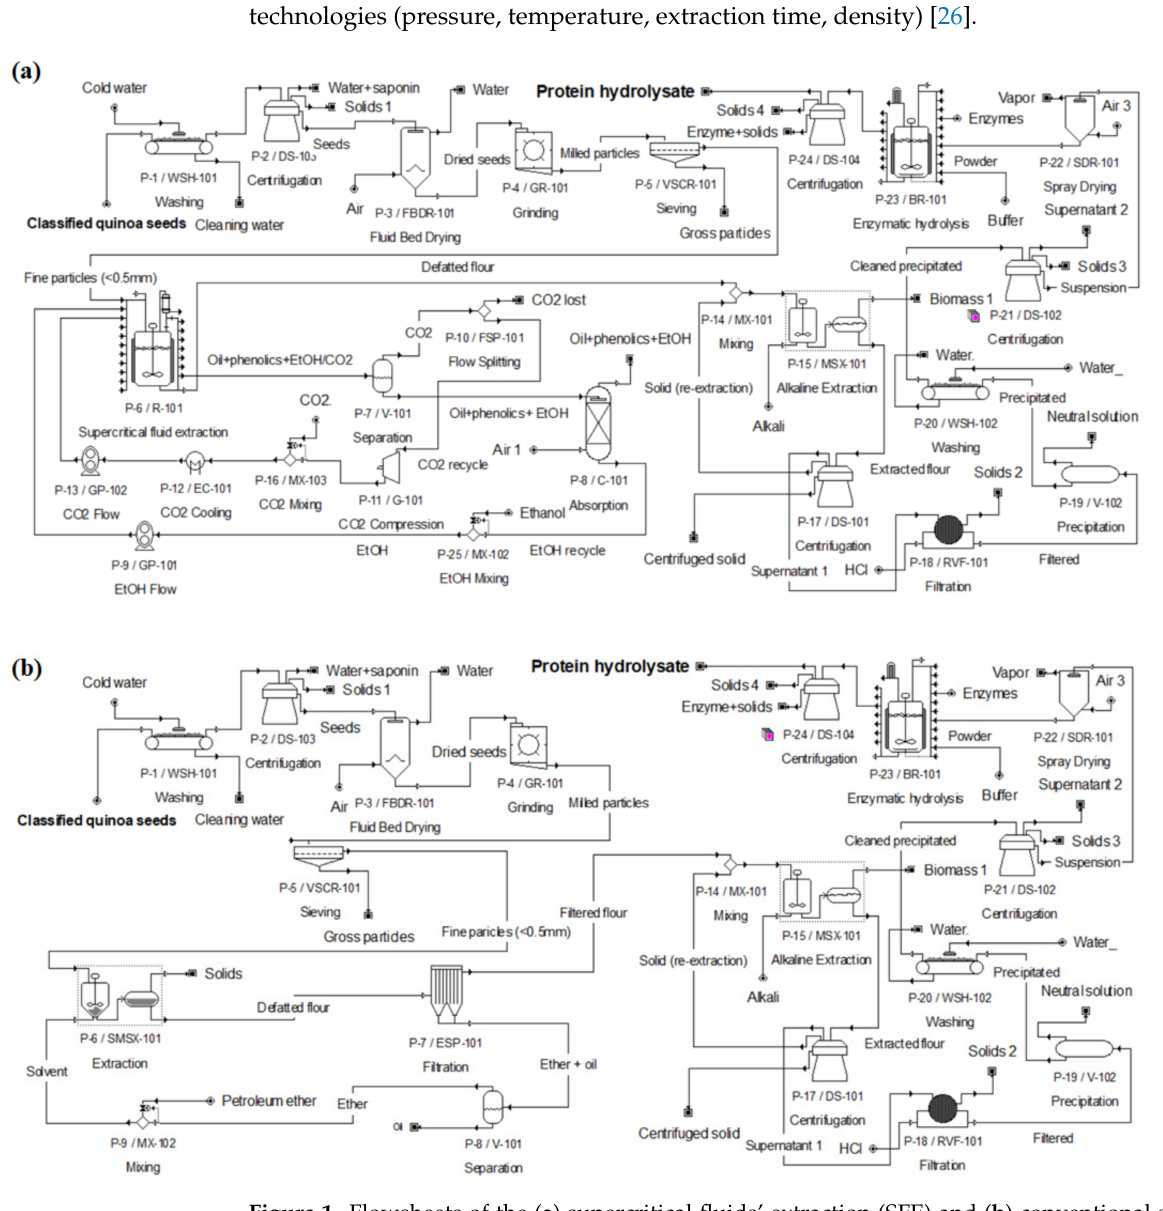
Figure 1. Flowsheets of the ( a ) supercritical fluids’ extraction (SFE) and ( b ) conventional solvent extraction (CSE) simulated with SuperPro Designer 9 ® for QPH production. Source: [18], repro- duced with permission from Olivera-Montenegro et al., The 2nd International Electronic Conference on Foods 2021—Future Foods and Food Technologies for a Sustainable World, sciforum-048913; published by MDPI,